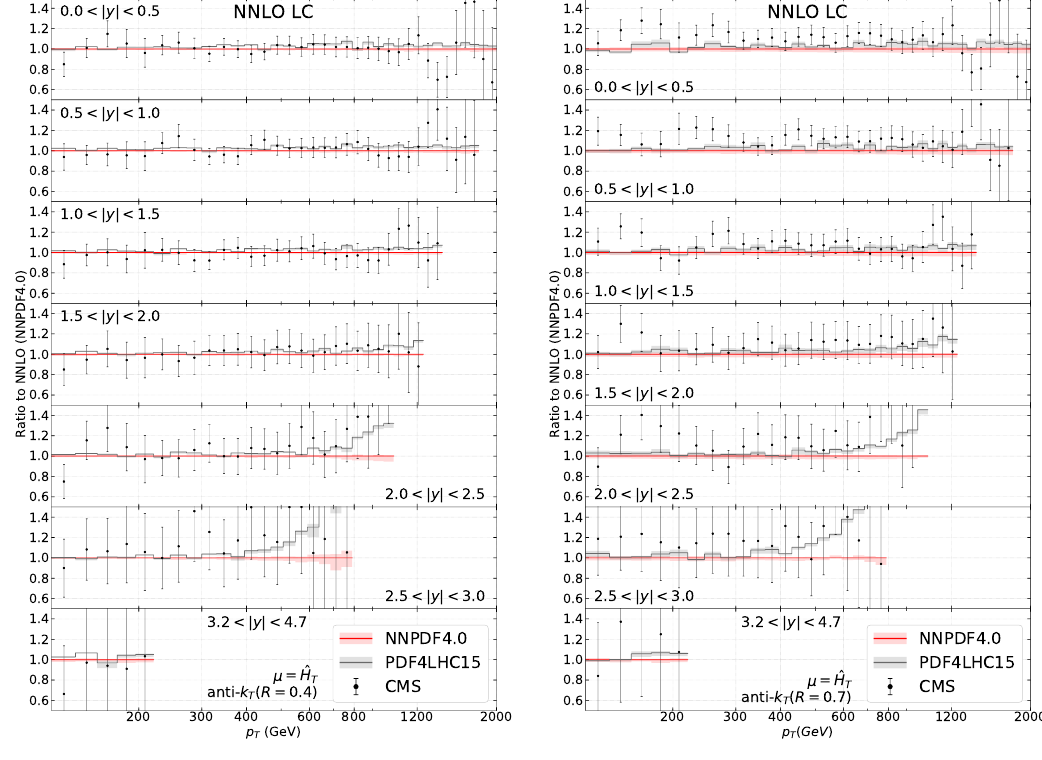
Figure 1 . Comparison of LC-only NNLO single jet inclusive distributions using PDF4LHC15_nnlo_100 (grey) and NNPDF40_nnlo_as_01180 (red) as the PDF for jet cone size R = 0 . 4 (left) and R = 0 . 7